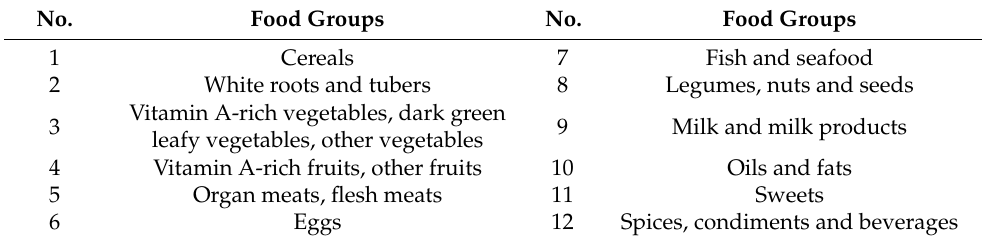
Table 2. Food groups used in this